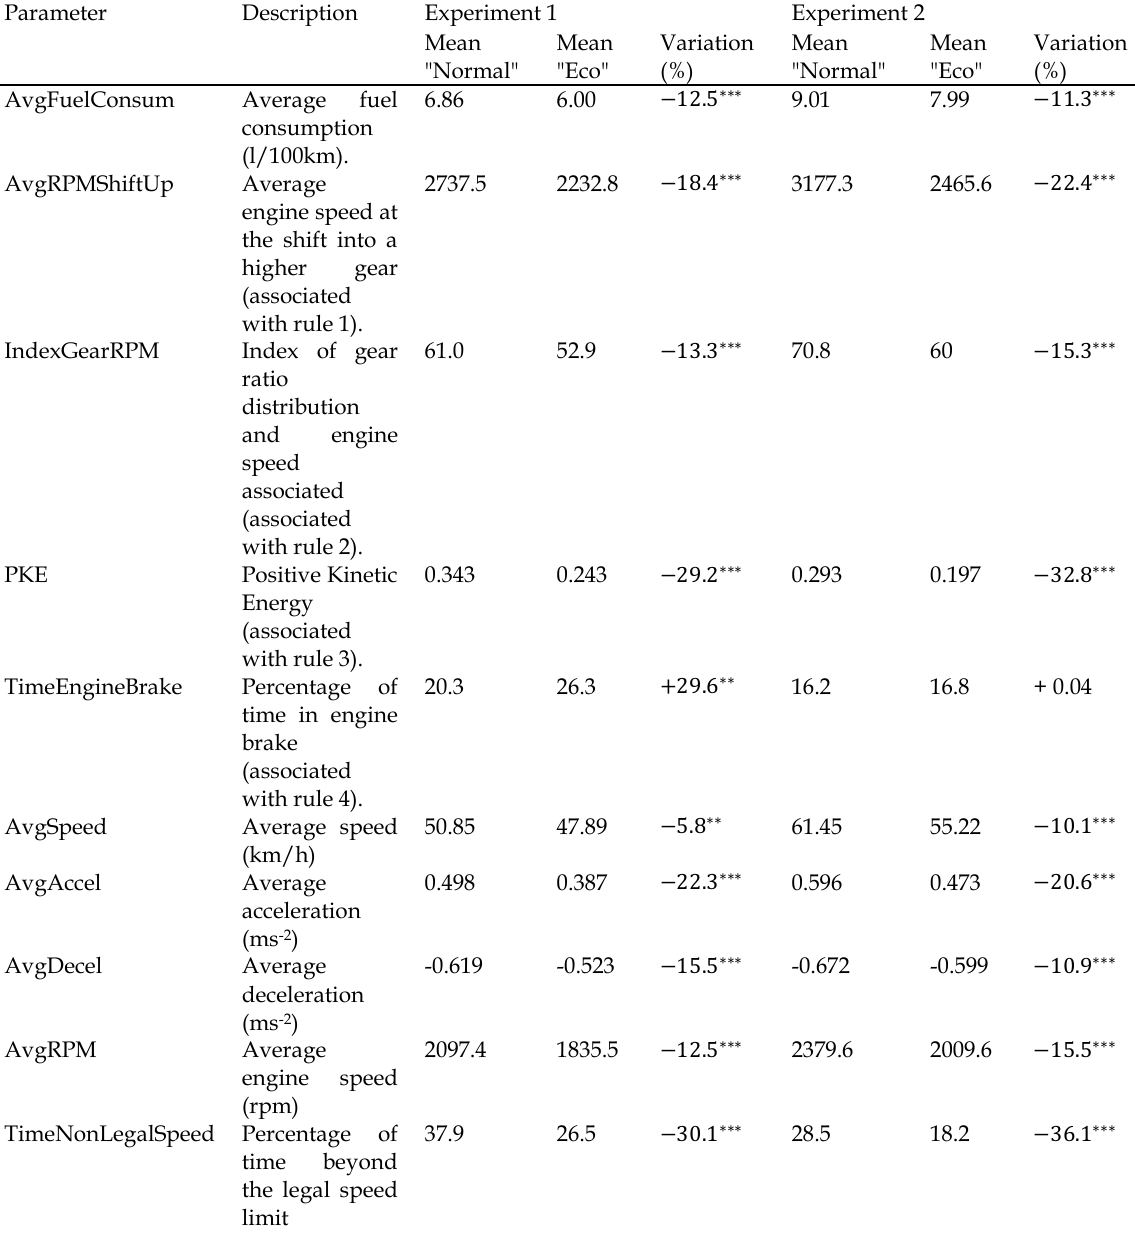
Table 2. Effects of eco-driving rules on different parameters